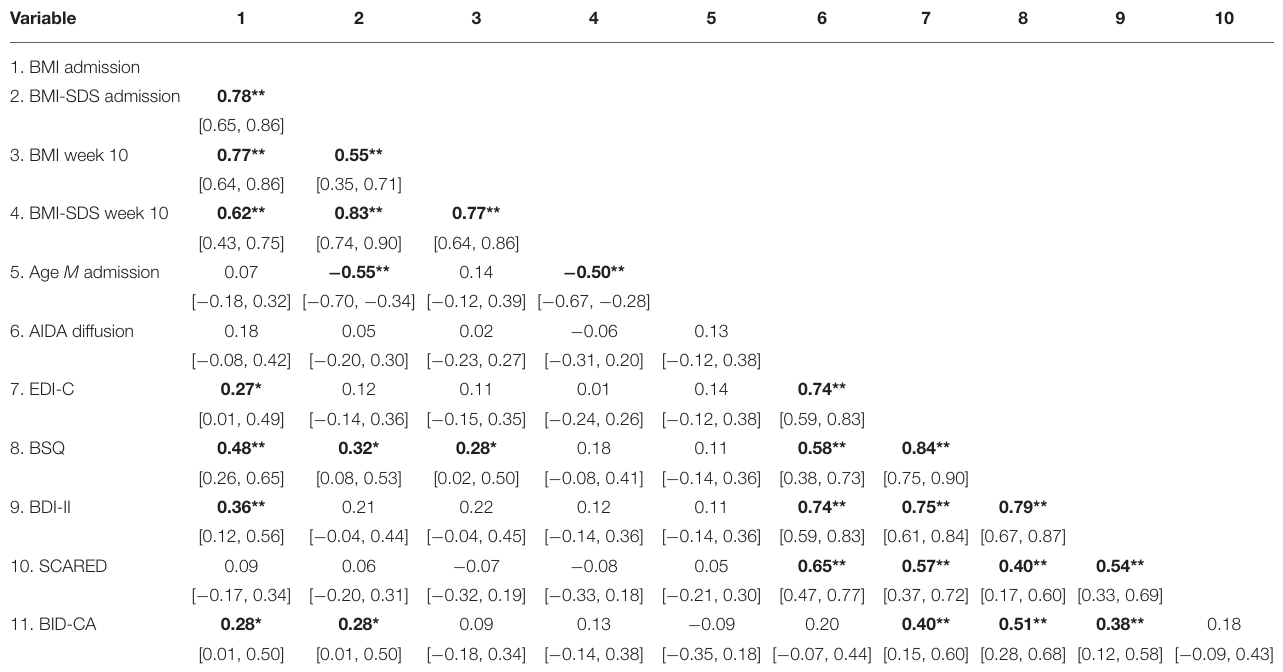
TABLE 2 | Correlations with confidence intervals. Variable